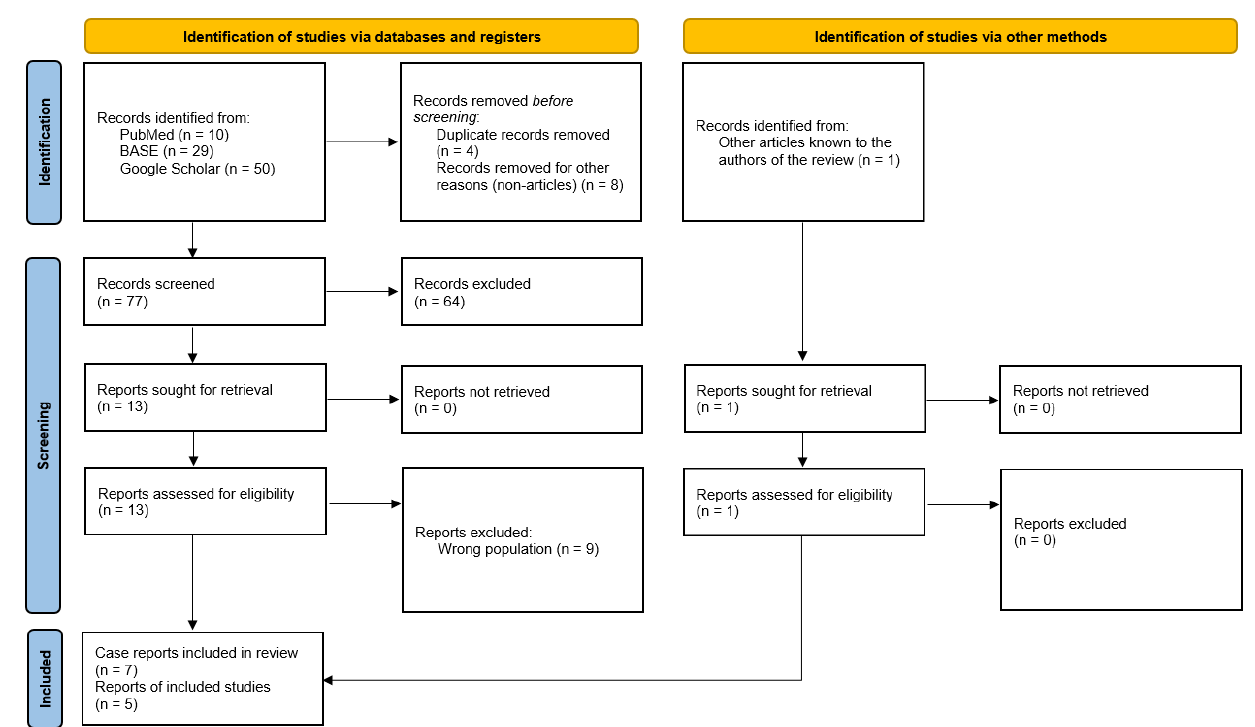
Figure 1. PRISMA 2020 flow diagram for new systematic reviews which included searches of databases, registers and other sources [5]. Table 3. Articles included in the systematic review.